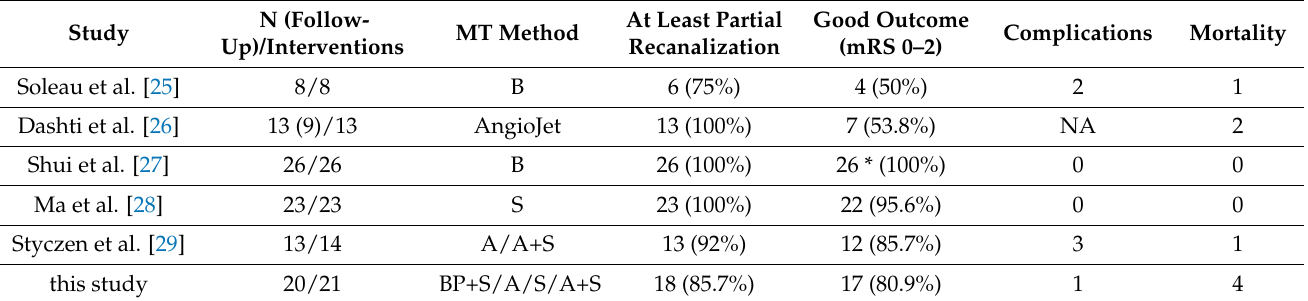
Table 4. Previous